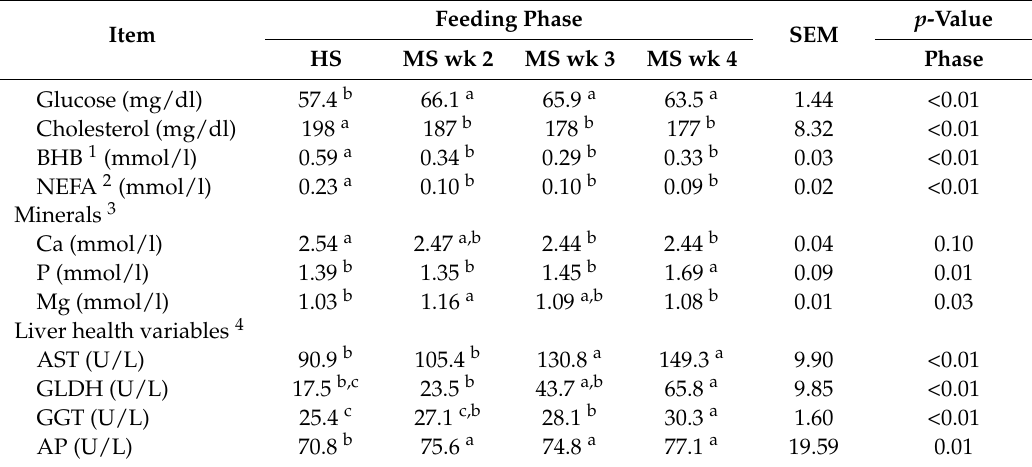
Table 6. Effects of the feeding phase on metabolites and blood minerals in cows fed either a 40% concentrate diet high in physical structure (24.4% peNDF > 8 mm DM basis; HS), or a 60%